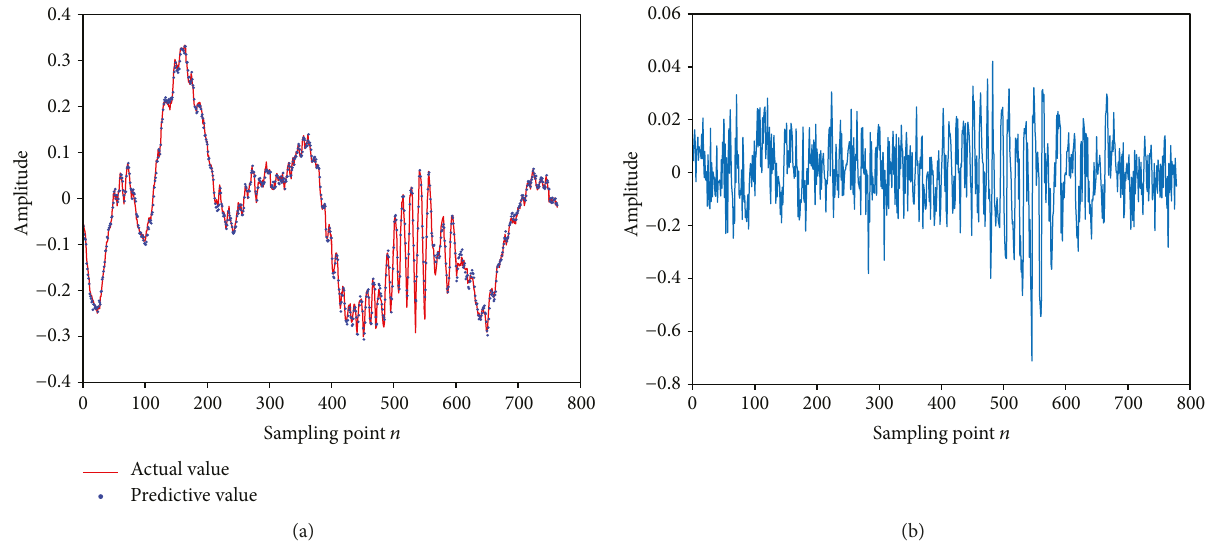
Figure 4: Chaotic prediction of the #54 8th distance gate sea clutter before de-noising. (a) Real value and Volterra predicted value. (b) The prediction